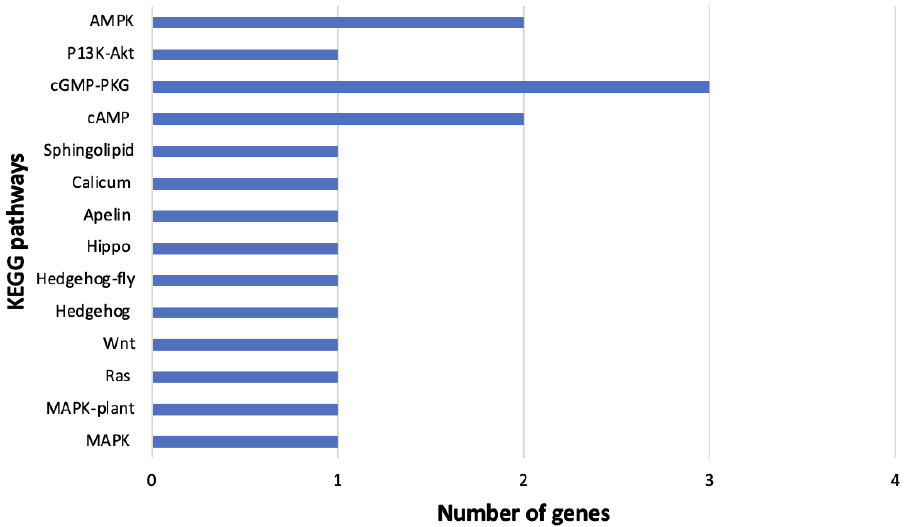
Table 3. Differential expression of genes associated with signal transduction in viruliferous com- pared with non-viruliferous Bemisia tabaci Middle East-Asia Minor 1 and Mediterranean (MED) adults.